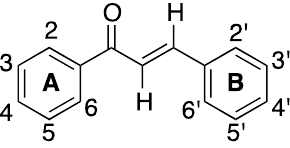
Figure 1. The general structure of chalcone.